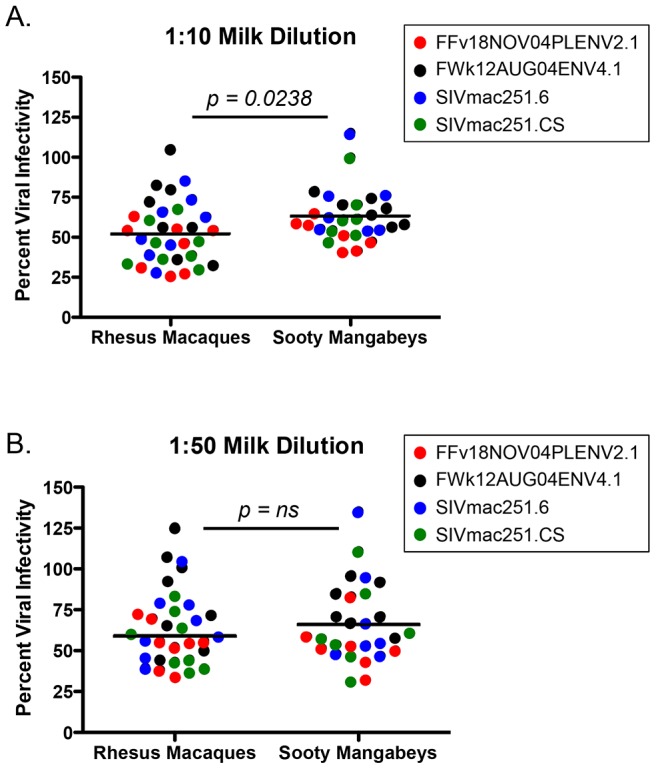
Inhibition of SIV infection by milk from RMs and SMs.The inhibitory capacity of serial dilutions of de-fatted breast milk from eight RMs and seven SMs against SIVsmm subtype 1 (FFv18NOV04PLENV2.1), SIVsmm subtype 2 (FWk12AUG04ENV2.1), SIVmac251.6 (neutralizing antibody-sensitive), or SIVmac251.CS (neutralizing antibody-resistant) viral envelopes was determined in the Tzm-bl neutralization assay. Comparisons between RMs and SMs were made at the dilutions where inhibition was seen. Adjusted against wells including no milk, percent viral infectivity in the presence of 1∶10 diluted (A) or 1∶50 diluted (B) milk is depicted on the vertical axis. Horizontal lines depict the median of each group. A nonparametric Mann-Whitney test was used to determine significance.